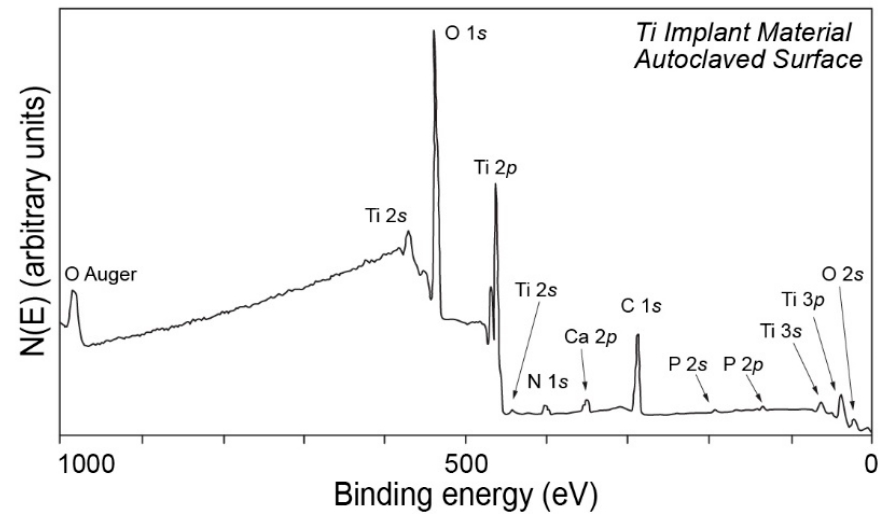
Figure 4. X-ray photoelectron spectroscopy (XPS) spectrum of a titanium implant surface revealing its composition. Figure adapted with permission from [39].